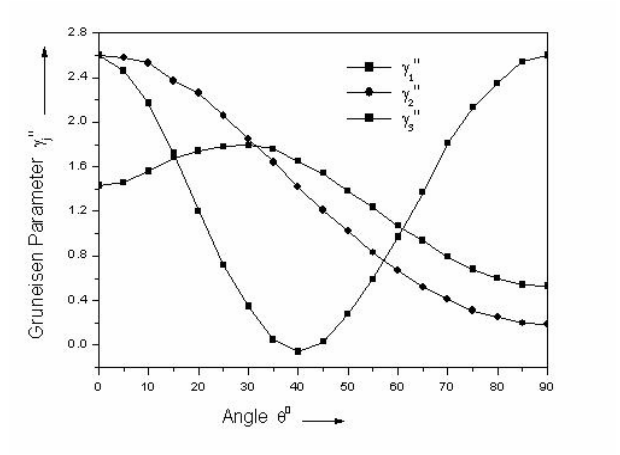
Figure 2 Variation of the generalized GP’s j g ¢¢ with angle q for the different acoustic waves in